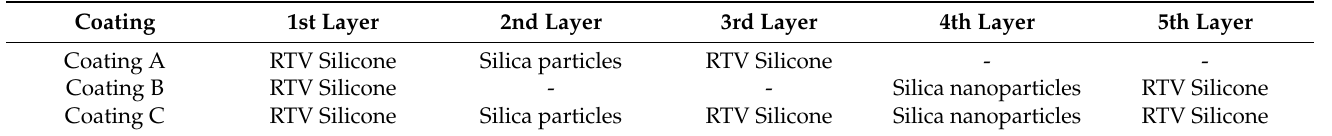
Table 1. Composition of different